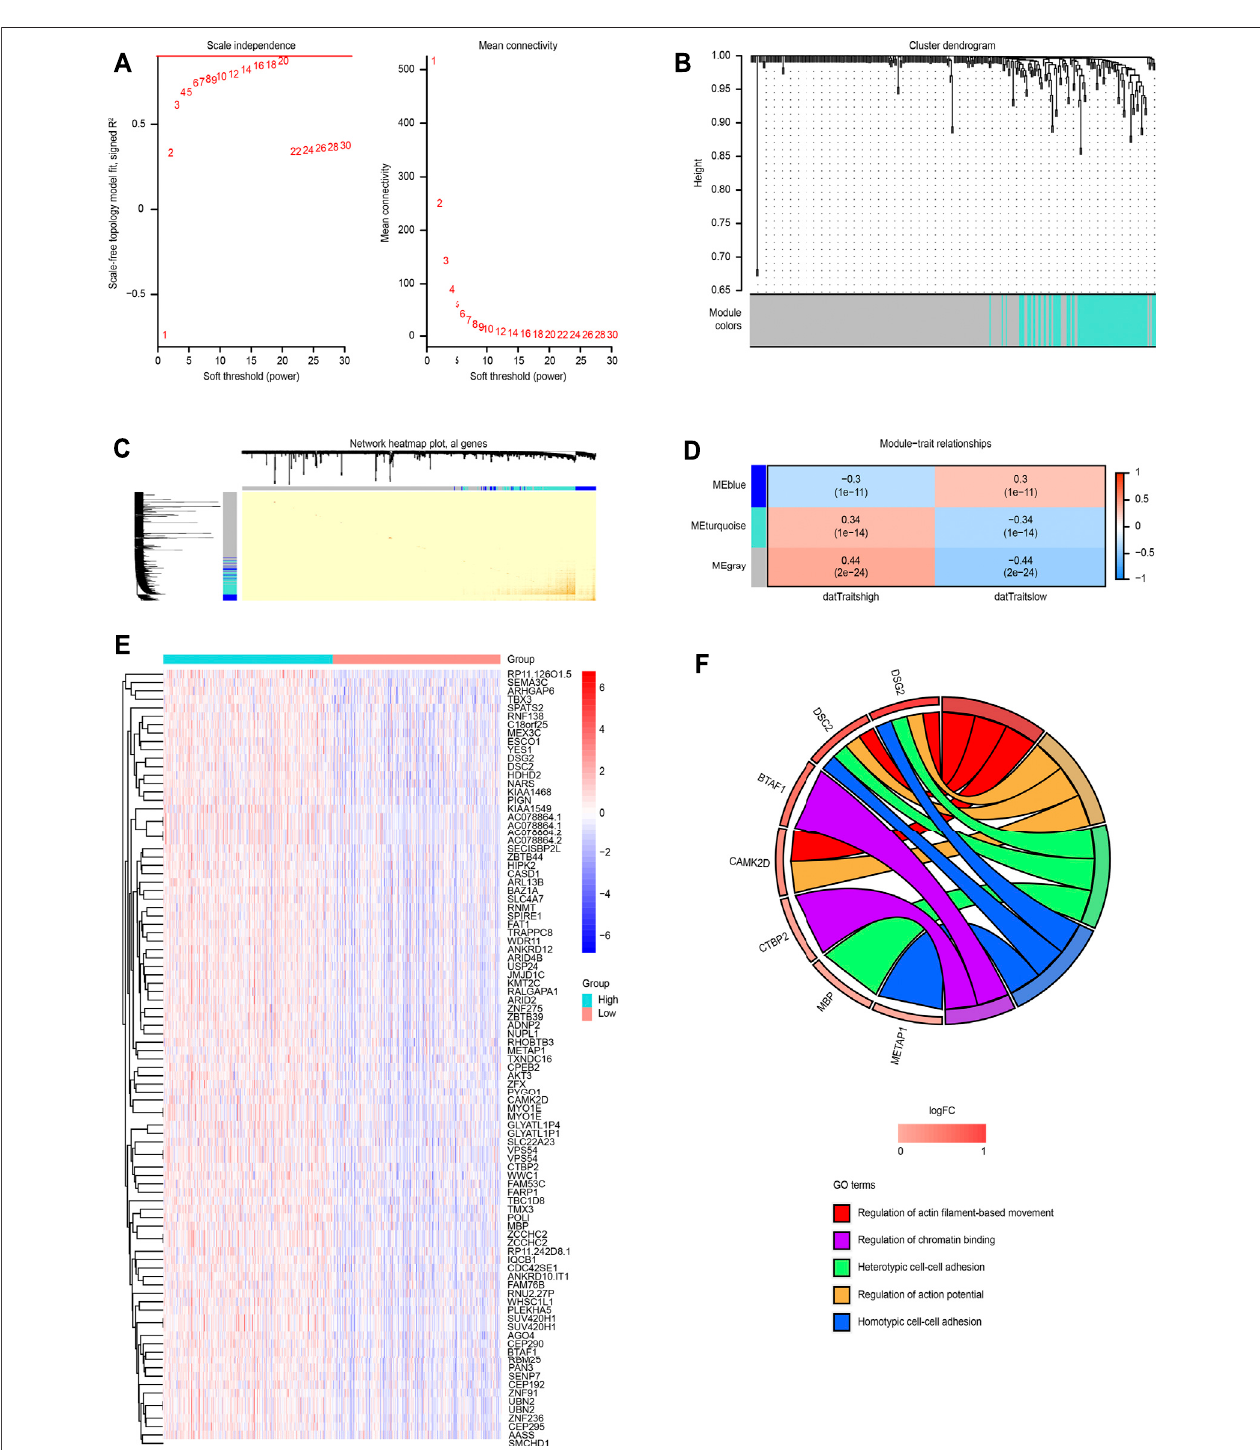
FIGURE 5 | WGCNA based on MALT1 expression and GO analysis. (A) Screening out the soft-thresholding power through scale independence and mean connectivity. (B) Gene clusteringtree(dendrogram) obtained byhierarchical clusteringofadjacency-baseddissimilarity. (C) VisualizationofTOMofco-expressedgenes in different modules by a heat map. Light colors indicate low overlap and dark red indicates high overlap. The darker color blocks along the diagonal are coexpression modules. (D) Module-trait relationship representing the relationship between modules and traits (high gene expression group, low gene expression group). The numbersinsideeachcellarethecoef fi cientvalueandPvalue,andthecolorofeachcellisassignedbasedonthecorrelationvalueofthemodule;redrepresentsastrong positive correlation, and blue represents a strong negative correlation, The stronger the correlation, the darker is the color. (E) Heat map of MALT1 coexpressed genes